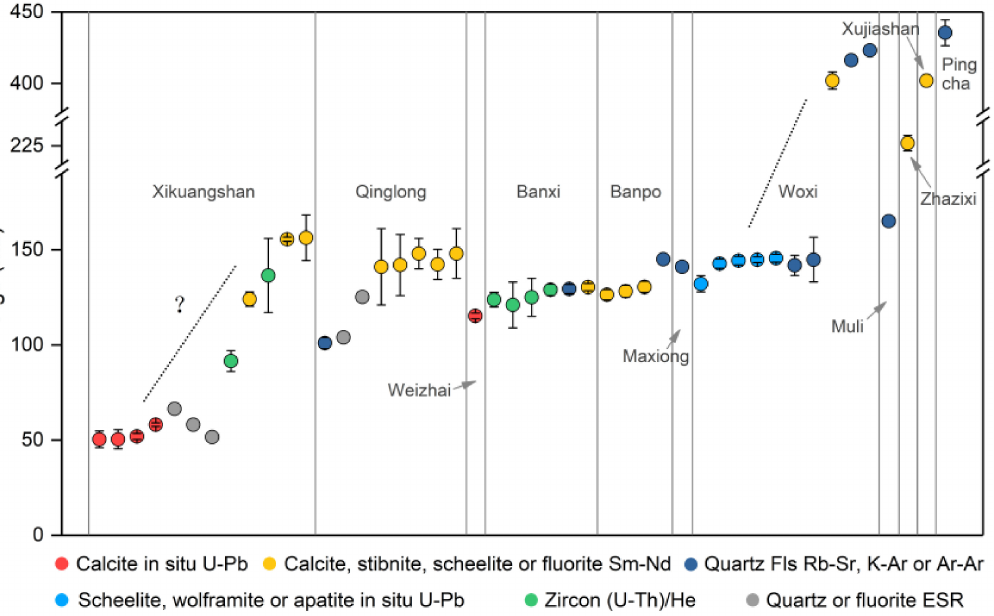
Figure 9. Age compilation of the South China antimony metallogenic belt (See Table 1 for details of data